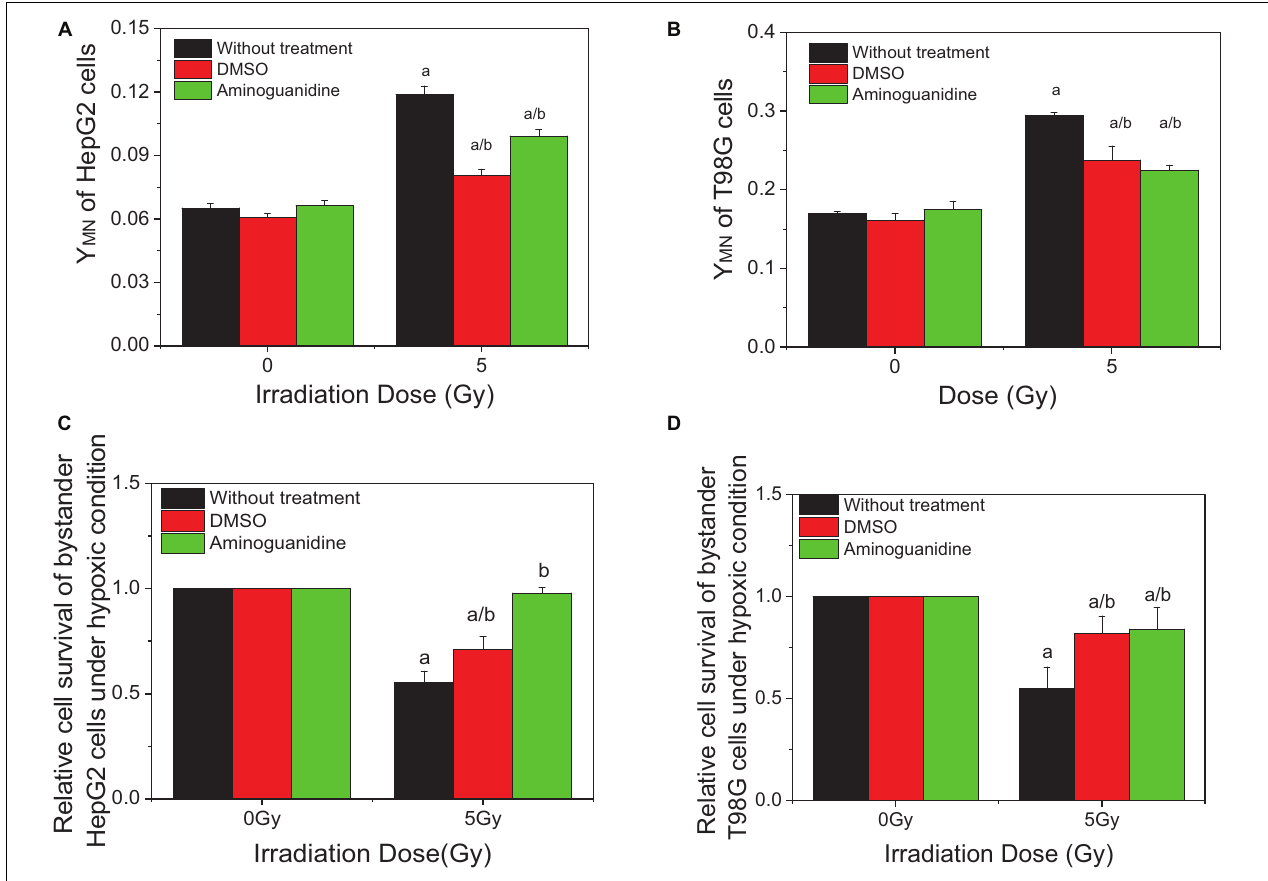
FIGURE 3 | Influence of DMSO and aminoguanidine (AG) on the bystander effect in HepG2 cells and T98G cells under hypoxic conditions. Bystander tumor cells were treated with the conditioned medium harvested from irradiated conspecific cells. (A,C) Micronucleus induction in the bystander cells. (B,D) Survival fractions of bystander cells. a, p < 0.05 compared with the 0-Gy group; b, p < 0.05 compared with the 5-Gy group without chemical